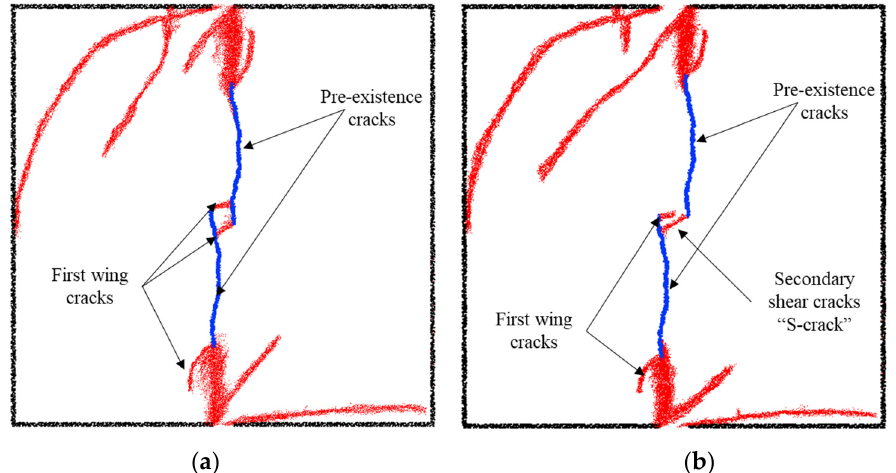
Figure 15. Failure mechanism in pre-cracked shear specimens with γ of ( a ) 50° and ( b ) 90°. Microcracks shown by the light blue dots.